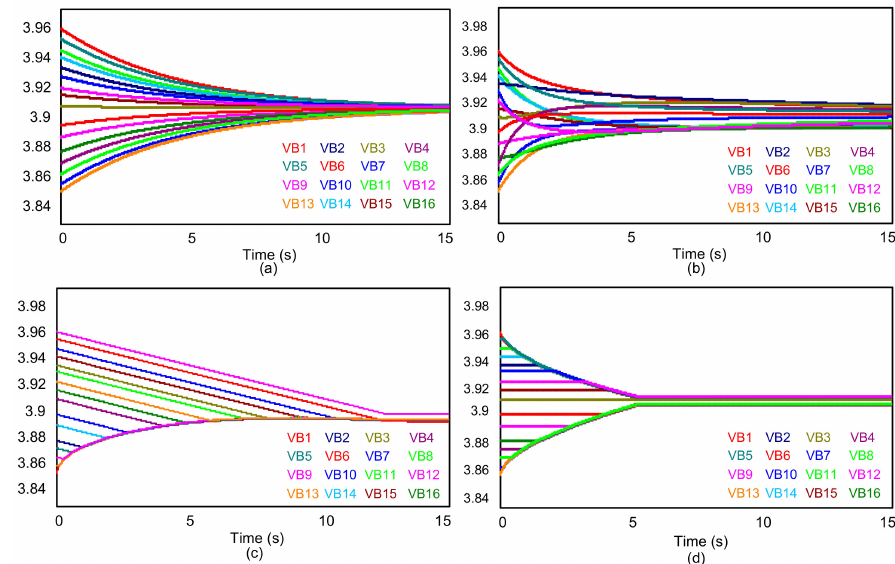
Figure 9. Simulation results of four different equalizers. ( a ) SCBE, C = 220 µ F, f = 10 kHz ( b ) CSSCE, C = 220 µ F, f = 10 kHz ( c ) BBLCRE, Vout-buck = 4.5 V, Cr = 100 µ F, Lr = 50 µ H, R = 0.2 Ω , f = 2230 Hz ( d ) SSIE, L = 100 µ H, f = 10 kHz.